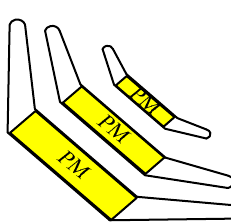
Figure 3. One pole geometry of S and Sd prototype SynRMs. ( a ) S prototype; ( b ) Sd prototype. Figure 4. Flux-barriers with inserted ferrite permanent magnets (PMs). Table 2. SynRM abbreviations.